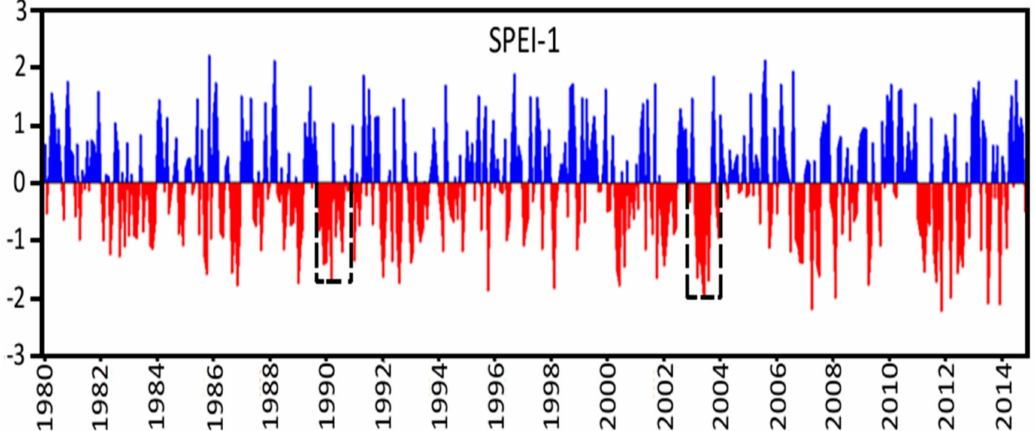
Figure 3. Time series of standardized precipitation evapotranspiration index for 1 month (SPEI-1) averaged over the Danube River Basin (DRB) during 1980–2014. Positive values are in blue and negative in red. The black rectangles show the development of the drought events in 1989/1990 and